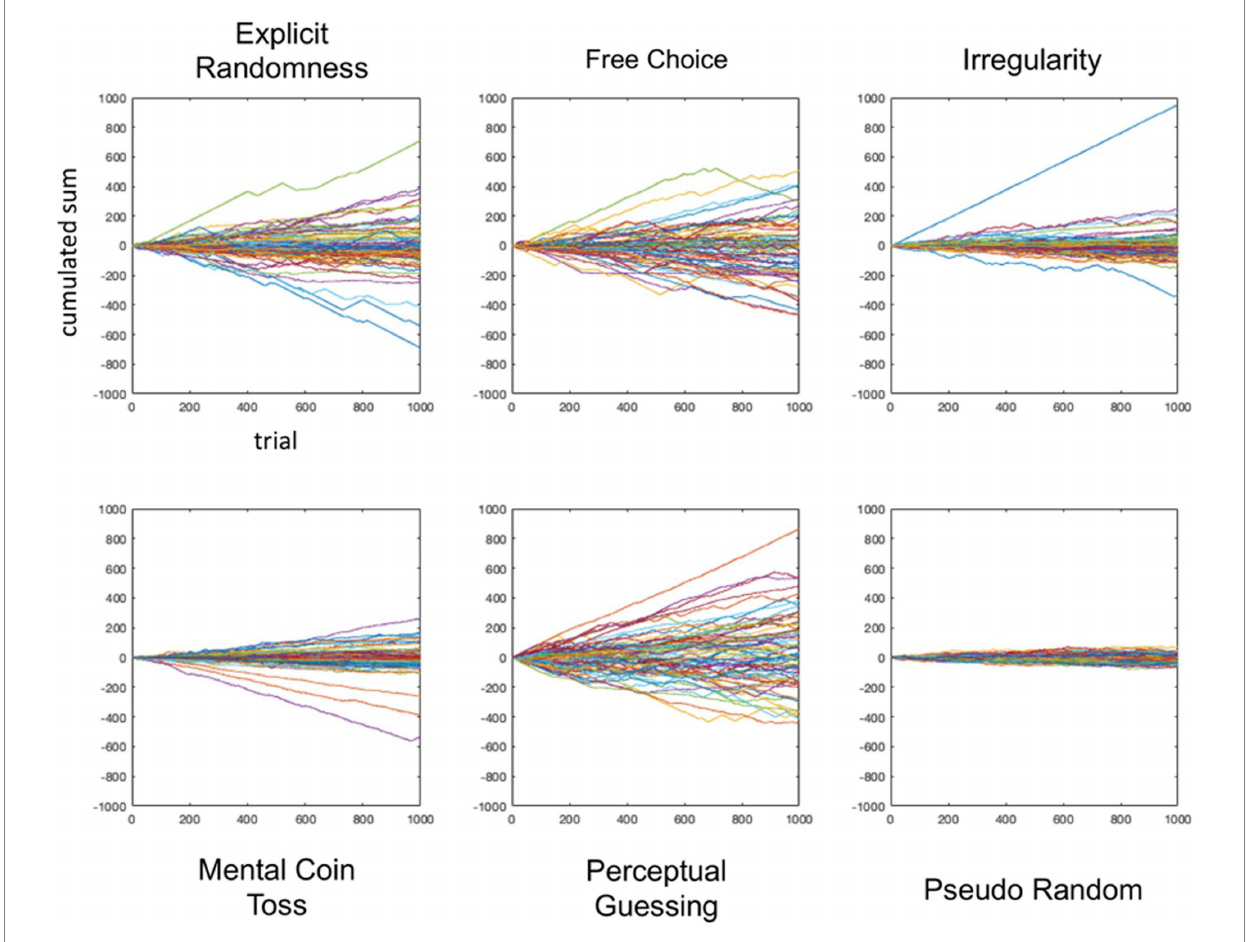
FIGURE 4 Plot of cumulative sum sequences for each condition. Every line is one